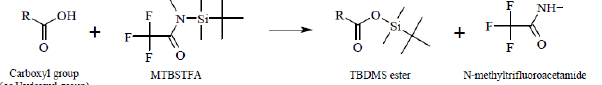
6 Fig. 2. Derivatisation reaction of carboxyl or hydroxyl compounds by the MTBSTFA reagent.